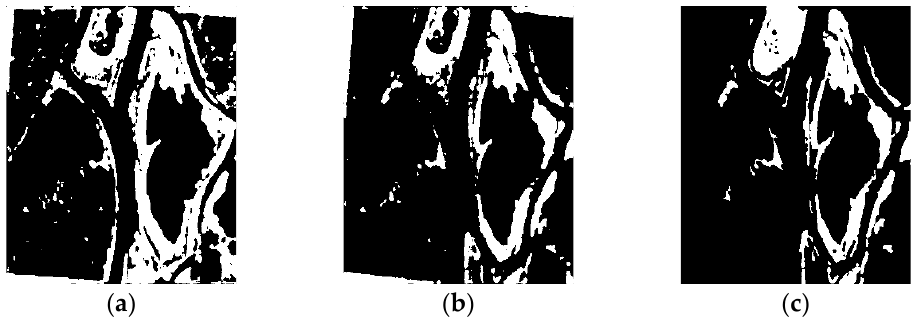
Figure 15. The change map: ( a ) SAR-SIFT, ( b ) the proposed method, and ( c ) the ground truth.